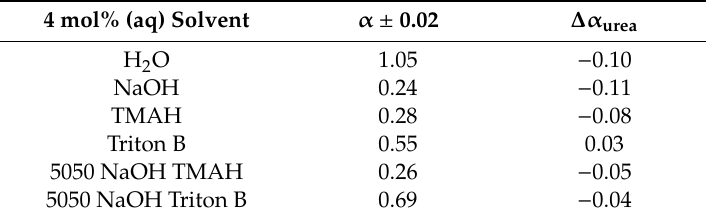
Table 4. The α parameters for the specified solvent and the di ff erence in alfa for the same solvent with urea. The values are an average of the values obtained at 15 and 35 ◦ C.